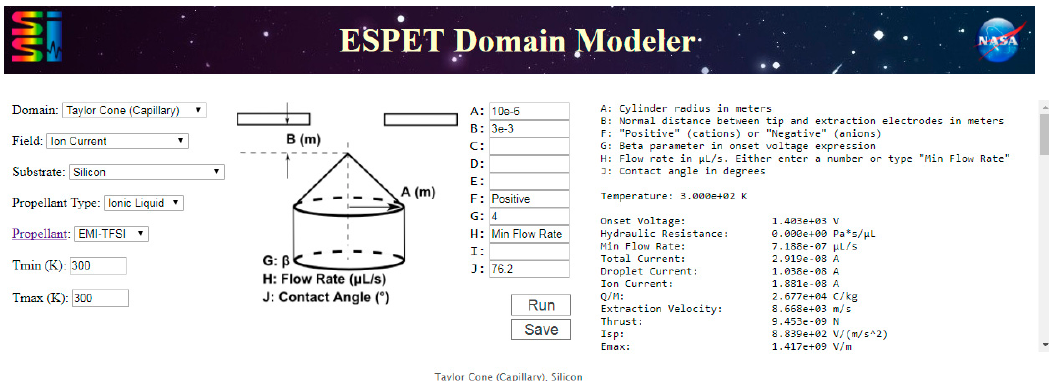
Figure 5. Screenshot of domain modeler with setup for the design of a capillary emitter.